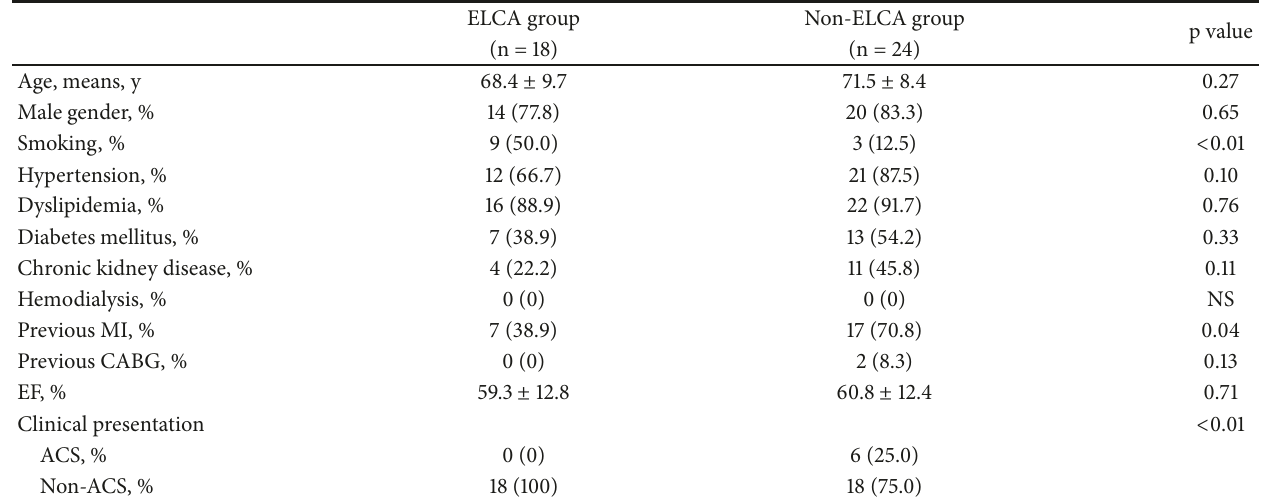
Figure 1: Morphology of dissections: (a) flap dissections and (b) cavities. Table 1: Baseline patient